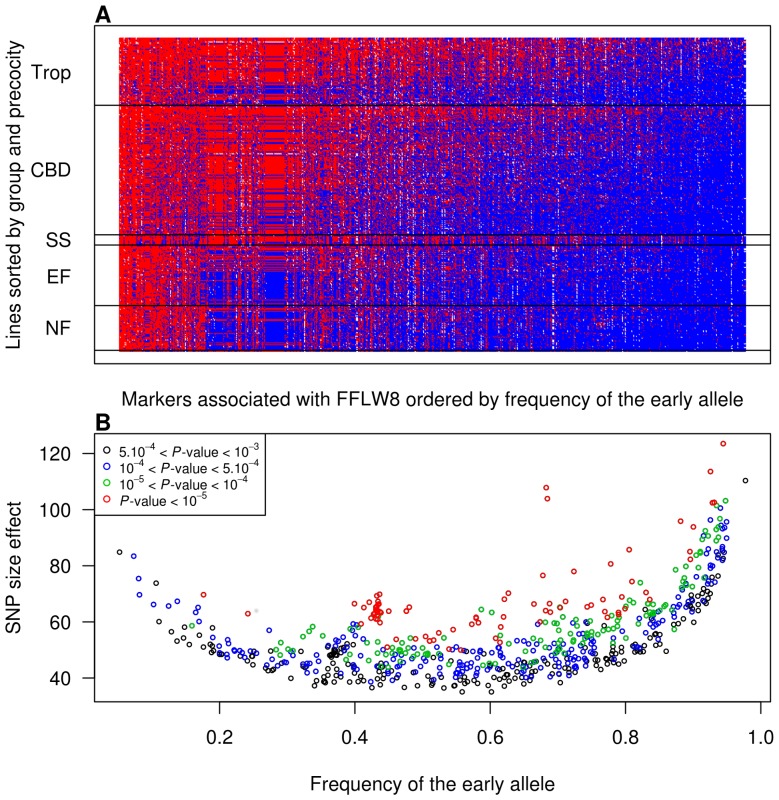
Distribution of SNP effects (GDD) according to the early allele frequency.In this figure, 673 markers with P-value<10−3 are represented. (A) For all inbred lines (rows) and SNPs (columns), red and blue colors correspond to the presence of late and early alleles, respectively. (B) The absolute SNP effect versus the frequency of the early allele for significant associations. Different colors correspond to different P-value thresholds.